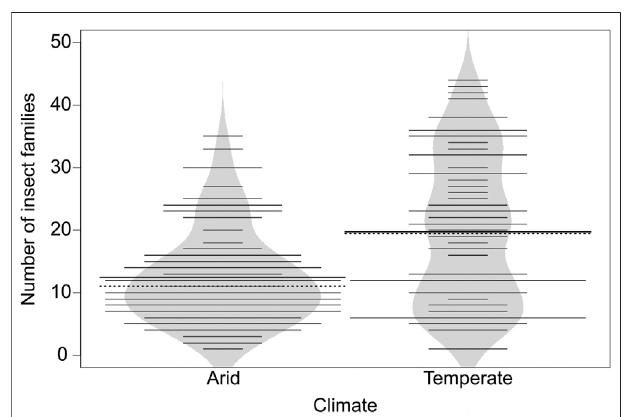
FIGURE 2 | Beanplot for number of insect families for arid (n (cid:1) 91) and temperate climate ( n (cid:1) 74) in Northwest Africa. Bold line indicates mean of each group (arid (cid:1) 12.44; temperate (cid:1) 19.76), dashed lines indicates median of each group (arid (cid:1) 11; temperate (cid:1) 19.5), thin lines